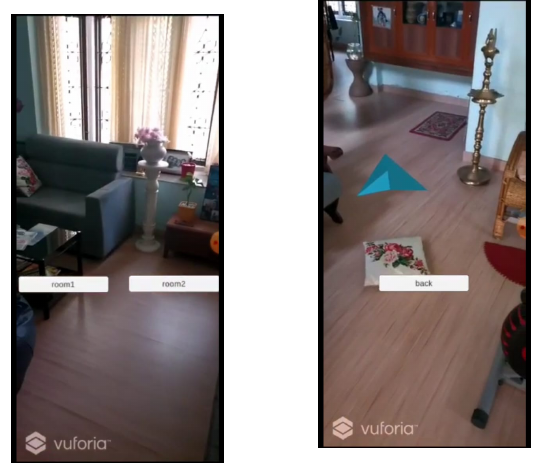
Figure 7. The initial node to the selected destination is